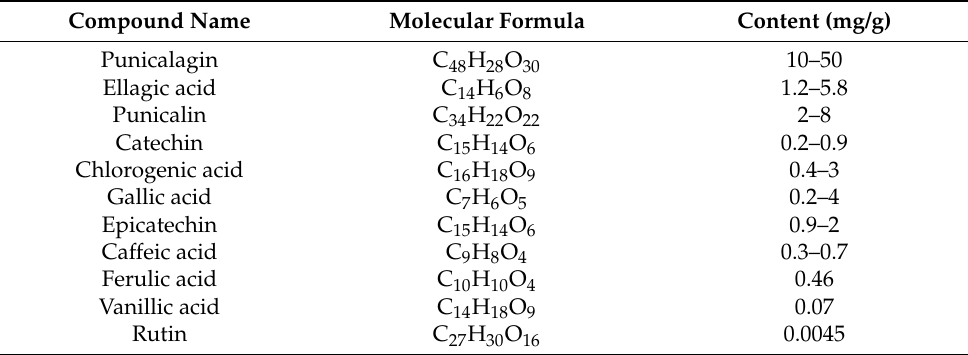
Table 1. The major phenolic compounds in pomegranate